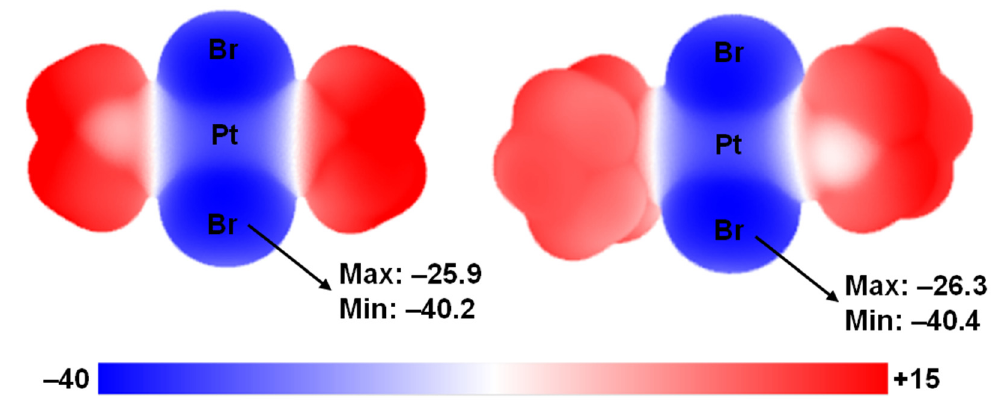
Figure 3. ESP on surface ( ρ = 0.001 a.u.) for 1 and 2 in kcal/mol.